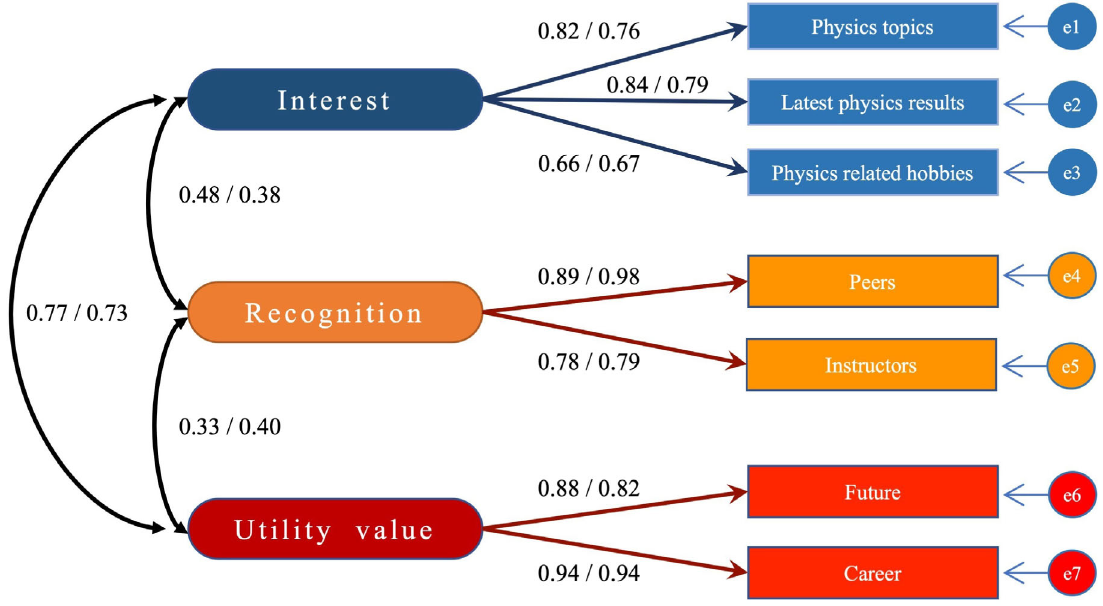
FIG. 3. Factor structure of the motivation to learn physics scale. The unobserved constructs ( factors ) are represented by rounded rectangles. The observed variables (i.e., the questionnaire items) are represented by rectangles. The single-headed arrows represent structural regression coefficients, namely the factorial loads of an observed variable onto the factor. Factor loadings tell how much the item is related to the factor and should not be confused with item mean values (see Fig. 4). The measurement errors associated to observed variables are represented by a circle and a small single-headed arrow near the corresponding variable. Two-headed black arrows represent the covariances of the constructs. For each factorial load and covariance we reported the value before and during remote instruction.